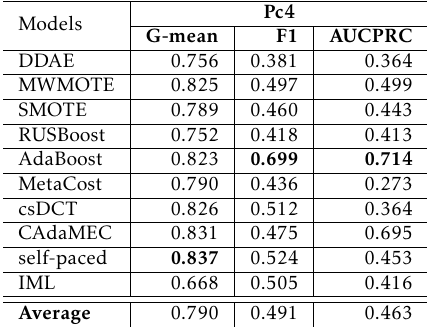
Table 20. Overall Results for Pc4 Dataset Models